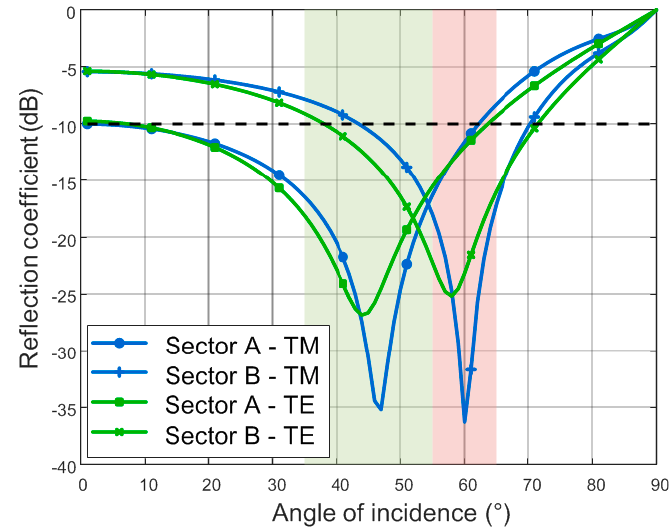
Figure 6. Reflection coefficient of sectorial absorbers A and B for both polarizations with respect to angle of incidence. TL model, 2.15 GHz.